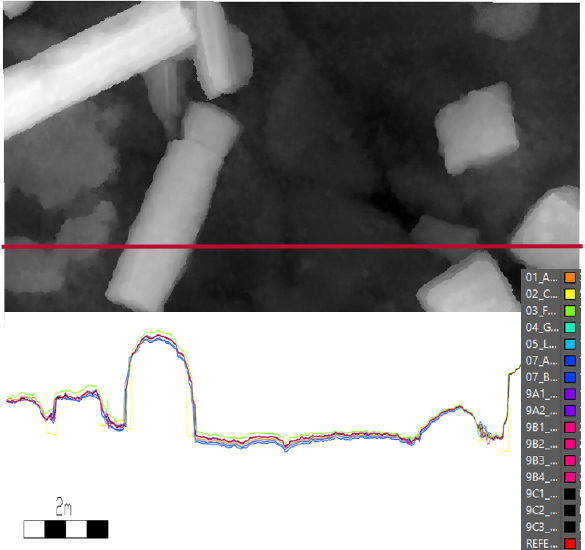
Figure 9. Position of the generated cross-section (above) and example of the sections extracted and compared